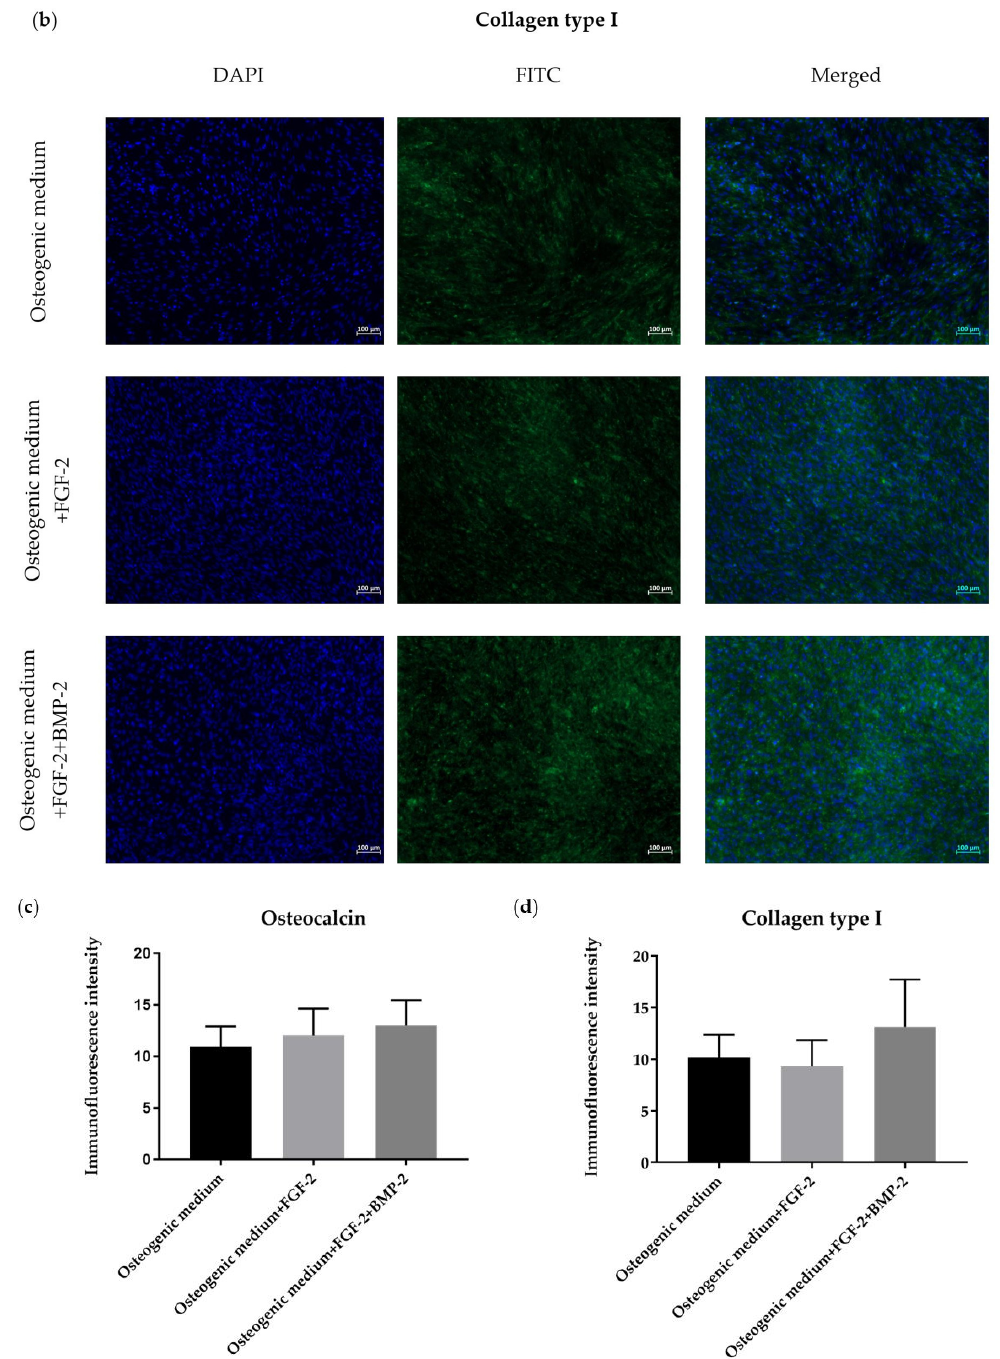
Figure 5. Representative images for the immunofluorescence staining of osteocalcin (Ocl) ( a ) and collagen type I (ColI) ( b ), expressed by BM-MSCs cultured in an osteogenic di ff erentiation medium with or without BMP-2 and / or FGF-2 for 21 days. The Ocl and ColI were stained with FITC in green and nuclei in blue with DAPI. Immunofluorescence staining for osteocalcin ( c ) and collagen type I ( d ) was quantified using the ImageJ software. FGF-2 and BMP-2 promoted the expression of osteogenic-related proteins, which resulted in a moderately more intense fluorescence in the treated cells compared to the control cells cultured in the osteogenic di ff erentiation medium